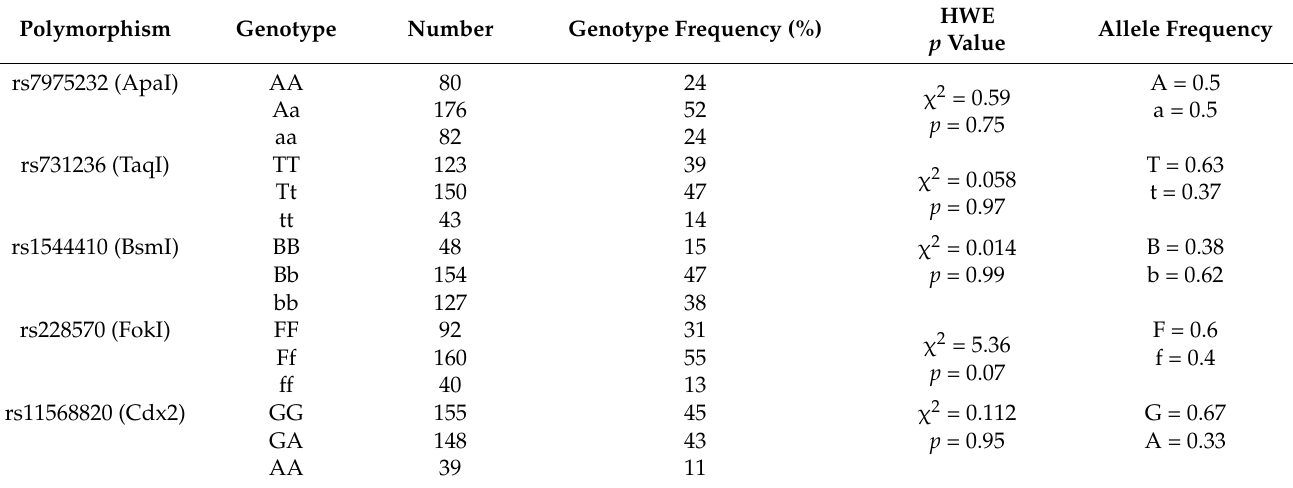
Table 2. Distribution of VDR genotypes and alleles.